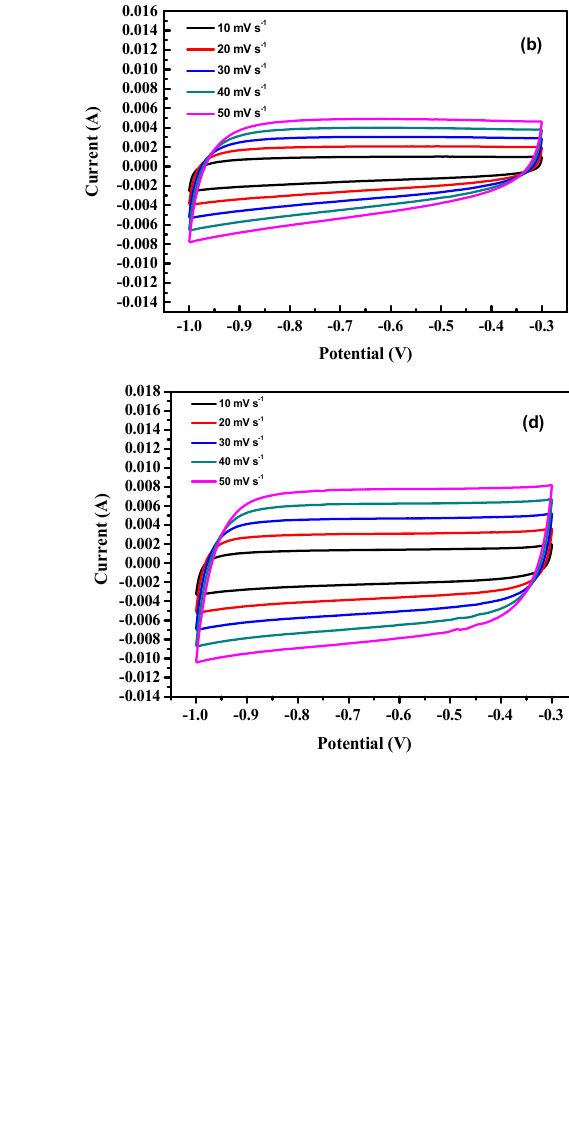
Figure 6. The degree of graphitization of the sample by the I D /I G -value of Raman shift ( a ); XRD pat- terns of the as-obtained different porous carbon ( b ).